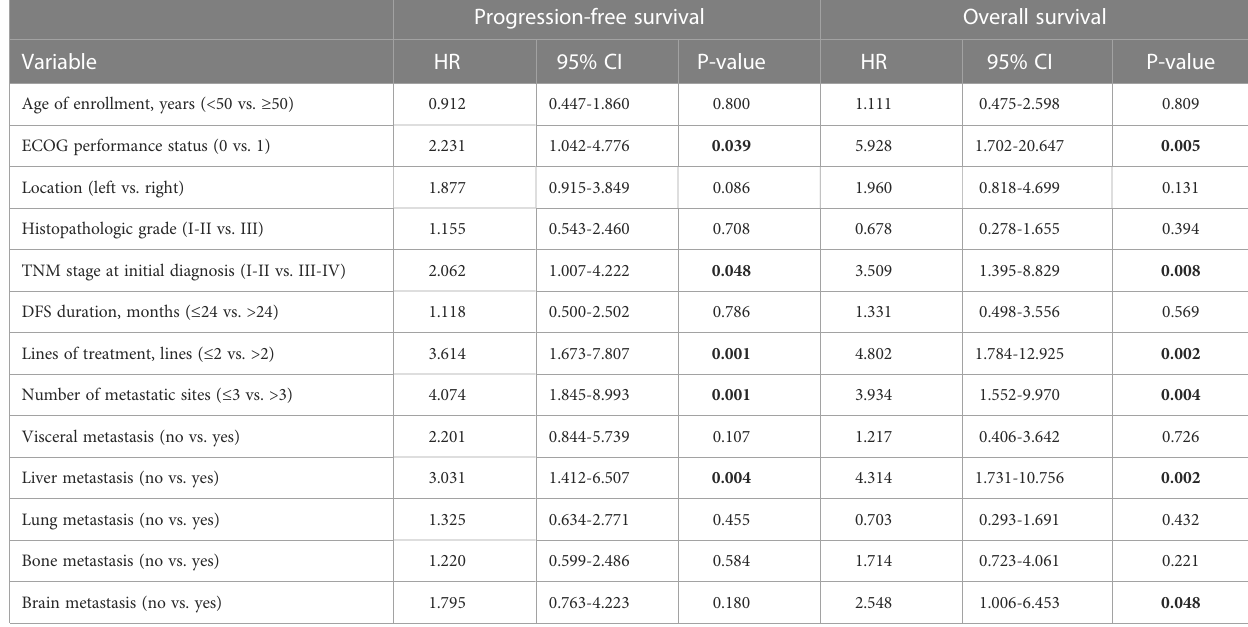
TABLE 3 Cox univariate regression analysis for progression-free survival and overall survival. Progression-free survival Overall survival